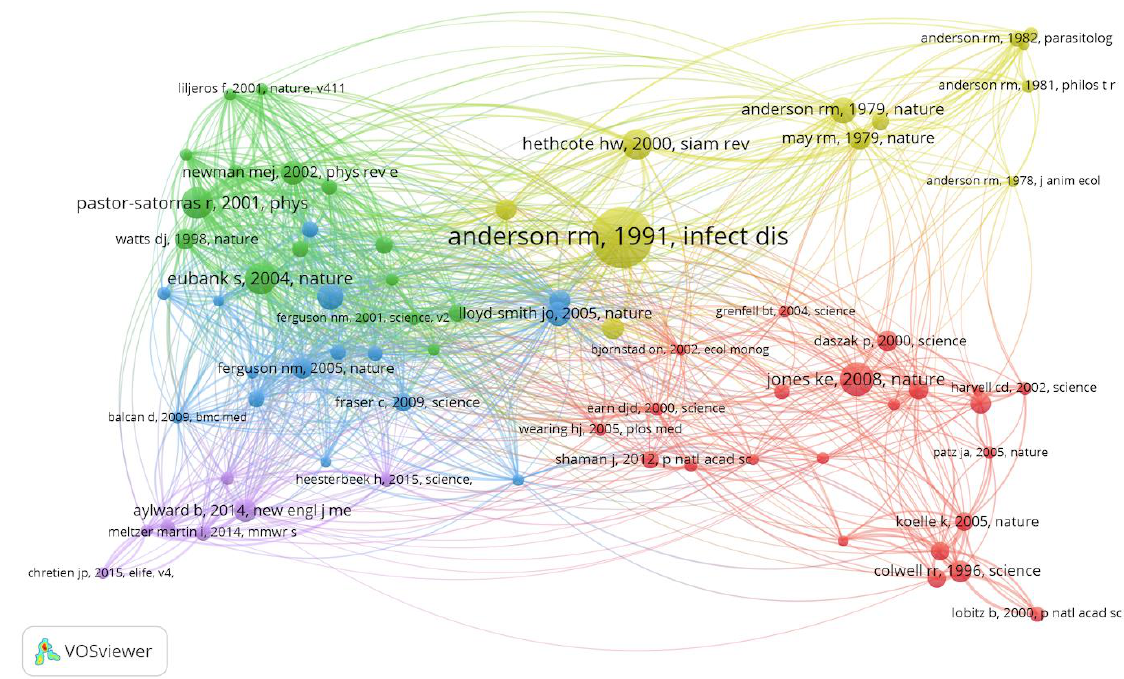
Figure 8. Co-cited reference network in the field of prediction of infectious diseases. Table 5. The top 10 cited publications in the field of prediction of infectious